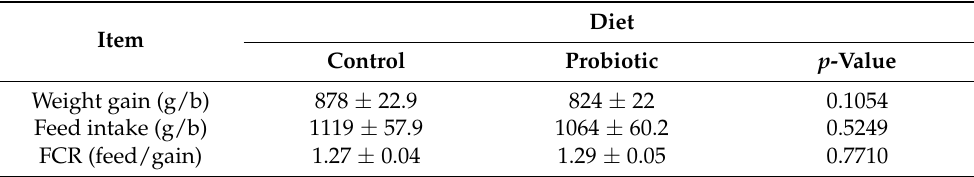
Table 1. Mean ( ± SEM) weight gains, feed intake, feed conversion ratios (FCR) by diet in ducks from days 1 to